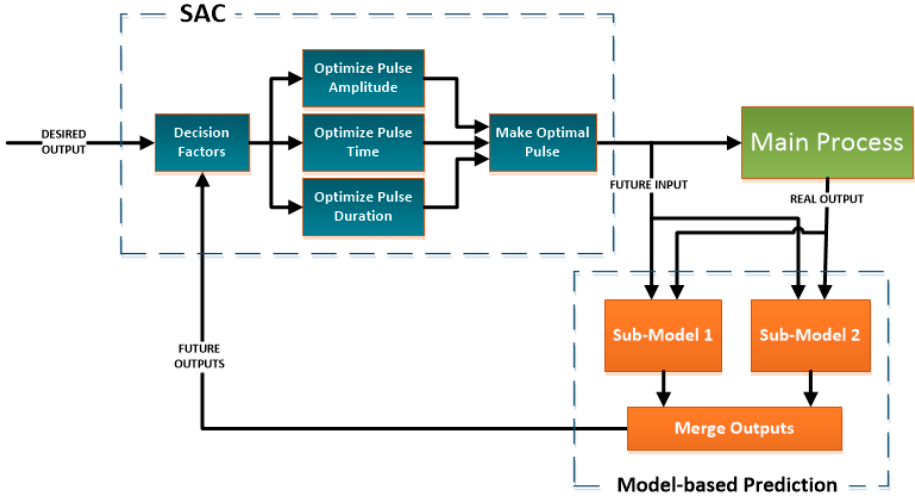
Figure 4. Control system diagram.